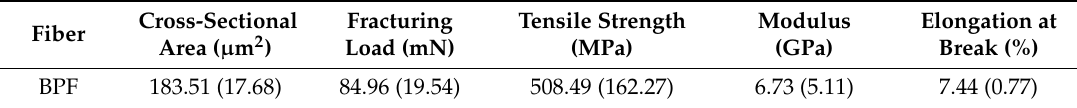
Table 3. The tensile property of